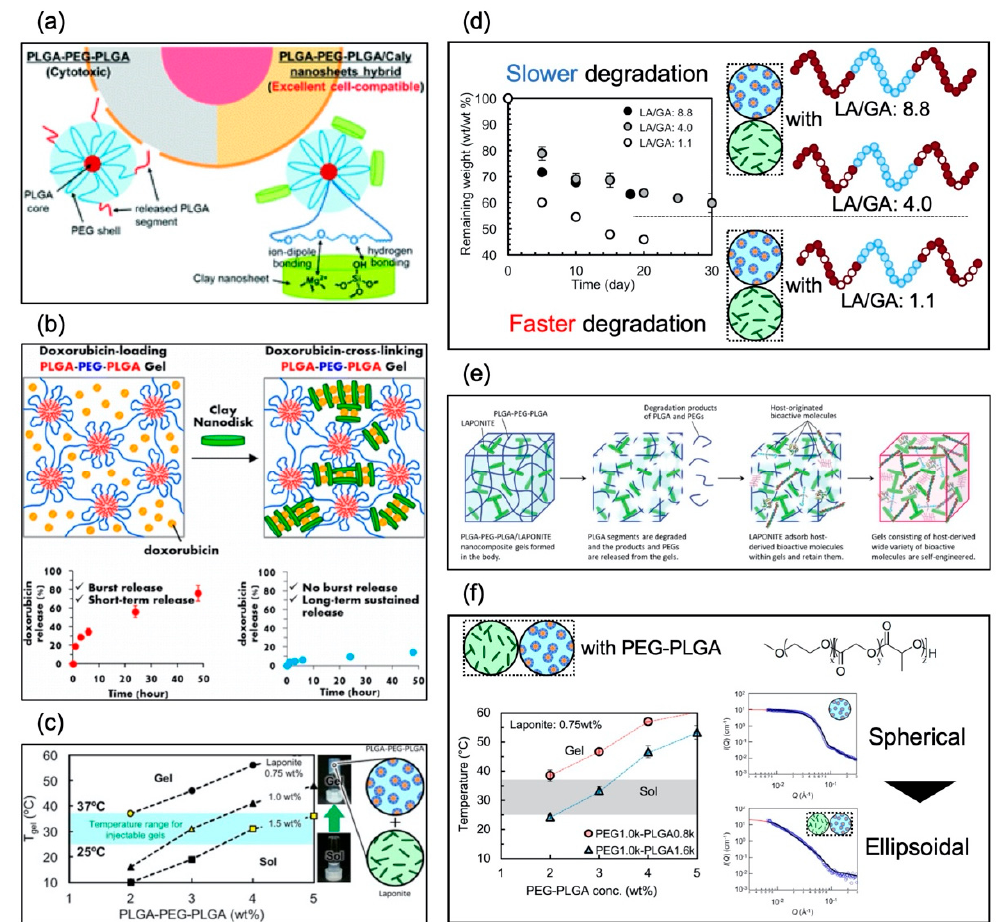
Figure 7. Graphical abstracts of nanocomposite systems reported in ( a ) June 2014 (reproduced from